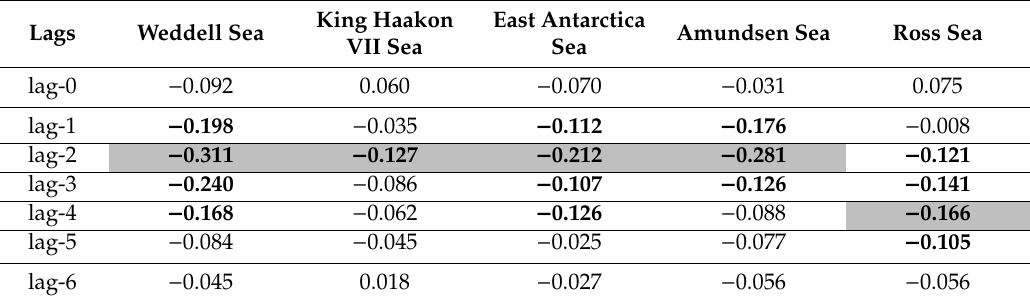
Table 1. Lagged correlation coe ffi cients between the anomalous (without annual cycle) time series of the moisture sink ((E − P)i10 < 0, but multiplied by -1) for each austral sea and the SIC. For example, lag-0 (0 month lag) uses the moisture sink and the SIC from January, lag-1 (1-month lag) uses the moisture sink from January and the SIC from February, and so on. Statistically significant values ( p -value < 0.05) are in bold. The strongest correlation obtained in each austral sea is highlighted in gray. King Lags Weddell Sea